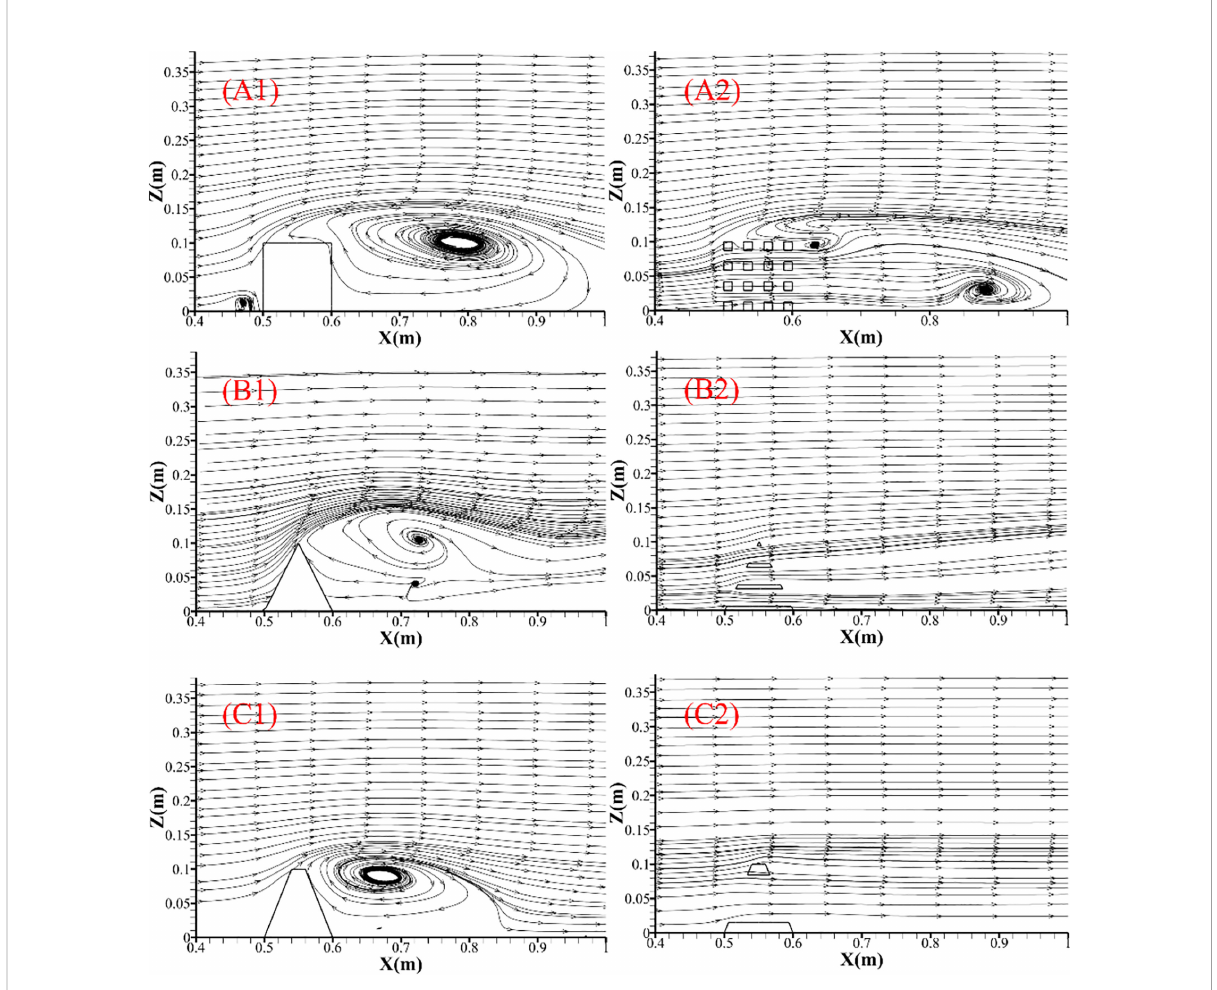
FIGURE 8 Streamline diagrams of the fl ow fi elds of ARs with six basic structures; (A1) Solid cube; (A2) Hollow cube; (B1) Solid triangular pyramid; (B2) Hollow triangular pyramid; (C1) Solid truncated rectangular pyramid; (C2) Hollow truncated rectangular pyramid.